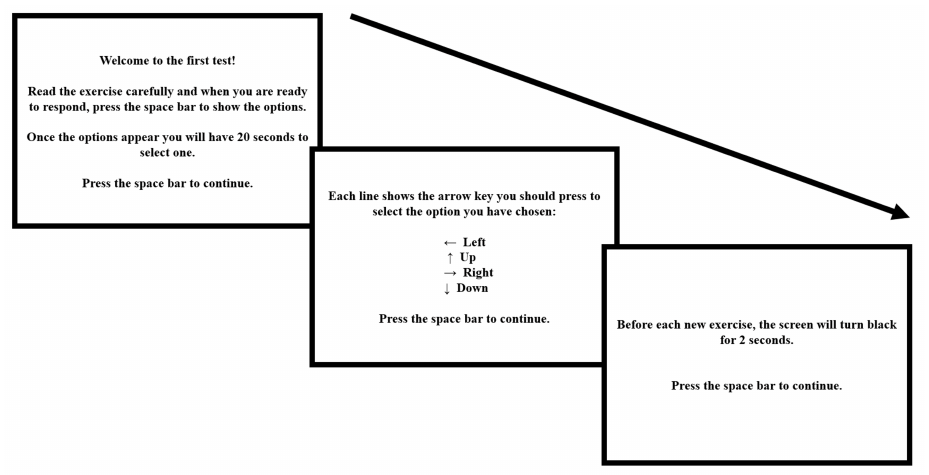
Figure 2. Instructions given to participants. Representation of the order in which the task instructions were displayed on the monitor.